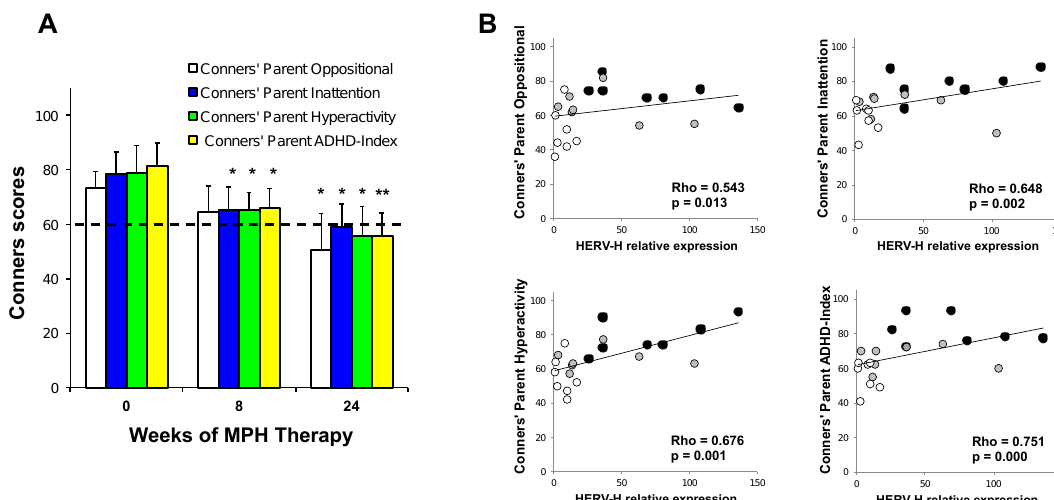
Figure 2. Clinical variables from Conners’ Parents Rating Scale-Revised (CPRS-R) and human endogenous retrovirus H (HERV-H) expression. ( A ) Mean values ± standard deviations (SD) of the four clinical variables (Conners’ parent oppositional, Conners’ parent inattention, Conners’ parent hyperactivity/impulsivity, and Conners’ parent ADHD-Index) in seven ADHD patients before the beginning of MPH therapy and after eight and 24 weeks. The dashed line represents the cut-off score. Single asterisk (*) indicates p values < 0.05 and double (**) indicates p values < 0.001. ( B ) HERV-H relative expression evaluated by real-time RT-PCR analysis plotted against the clinical variables. The patients are represented according to the time points by different colors: black for patients at the beginning of therapy, grey for patients analyzed after eight weeks of therapy, and white for patients after 24 weeks of therapy. Rho and p values for Spearman correlation analysis are shown.